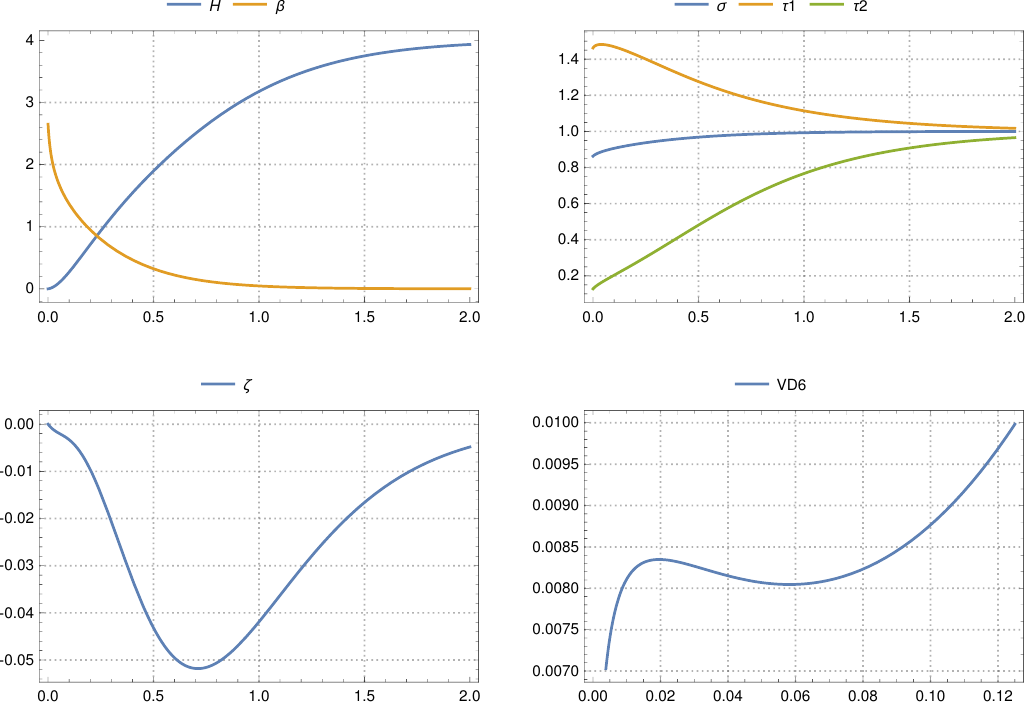
Figure 8 . Planar solution with purely electric charges pξ 1 = − 5 . 58 , pξ 2 = − 2 . 84 and r H = 1 . This solution has temperature T = 0 . 01 . The flux through the D6 brane probe is given by f = 0 . 66 . Probe D6 branes with f = 1 are unstable on this background solution. Notice the different scale of the horizontal axis (coordinate u ) for the bottom right figure.